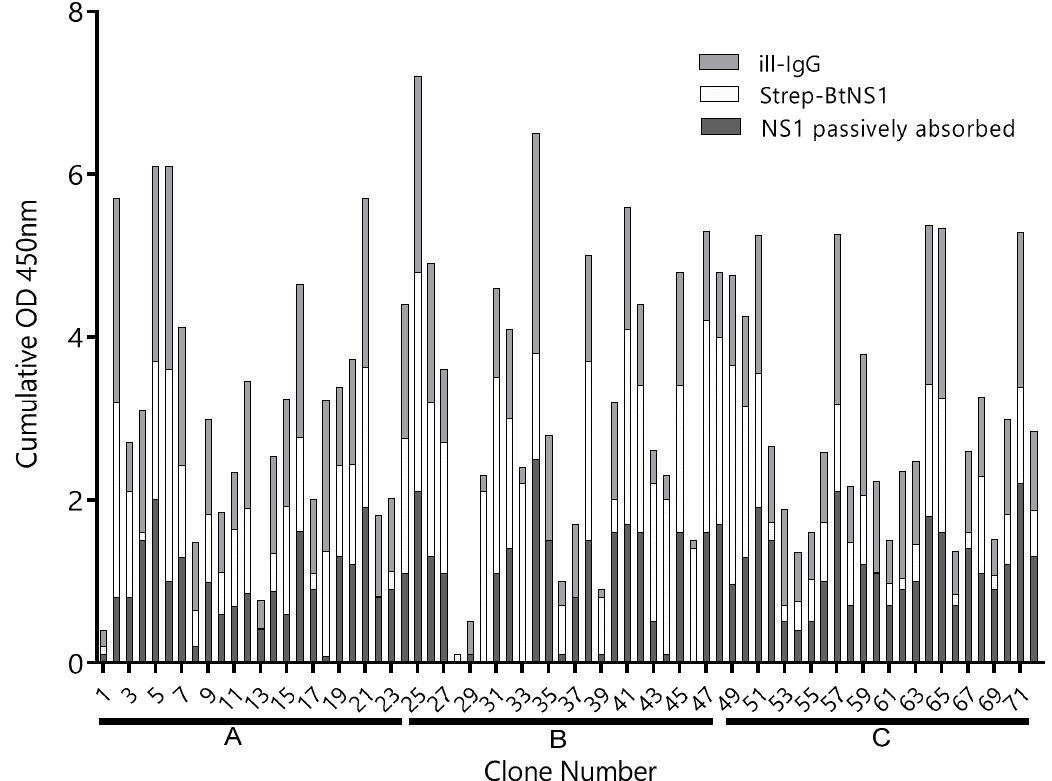
Figure 1. Reactivity of clones selected by different strategies. The supernatant of 24 Nb clones selected using the A, B, and C panning conditions—clones 1–24, 25–48, and 49–72, respectively—were tested by ELISA on plates coated with Zika virus NS1 (ZVNS1) immobilized using the A (dark gray), B (light gray), or C (gray) strategies. ill-IgG: immune llama immunoglobulin G and BtNS1: biotinylated NS1. Optical density at 450nm (OD450nm) was measured.